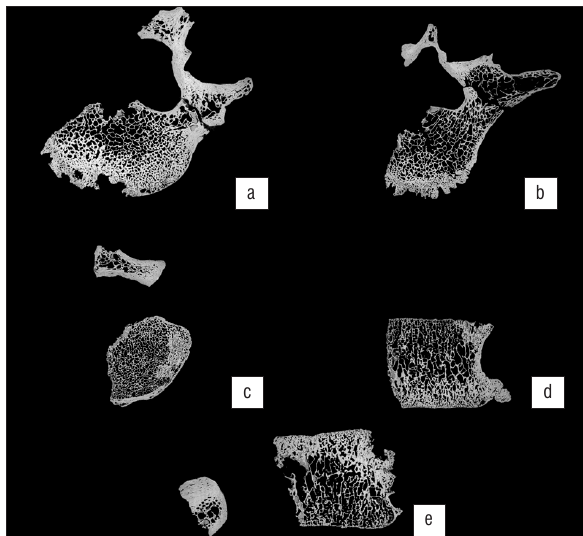
Figure 5: Micro-CT orthoslice views of the L5 vertebra of StW 431: (a,b) transverse to the midline (close to surface), (c) transverse to inferior, (d) coronal midline, (e) sagittal superior to bottom. Note new bone formation on the anterior wall (e) and major osteophytic formation at the antero-superior margin indicating remodelling of the cortex, revealing a sclerotic margin, and as crenulated buttresses of porous bone devoid of internal trabeculae (a,b). There is no evidence of sclerosis or reactive bone formation around the cavity margins (a). The inferior endplate (c) exhibits an osteophytic formation as a thin ordered sclerotic rim around inferior circumference with no presence of buttressing. Notice the channel interpreted as invertebrate damage in (e).